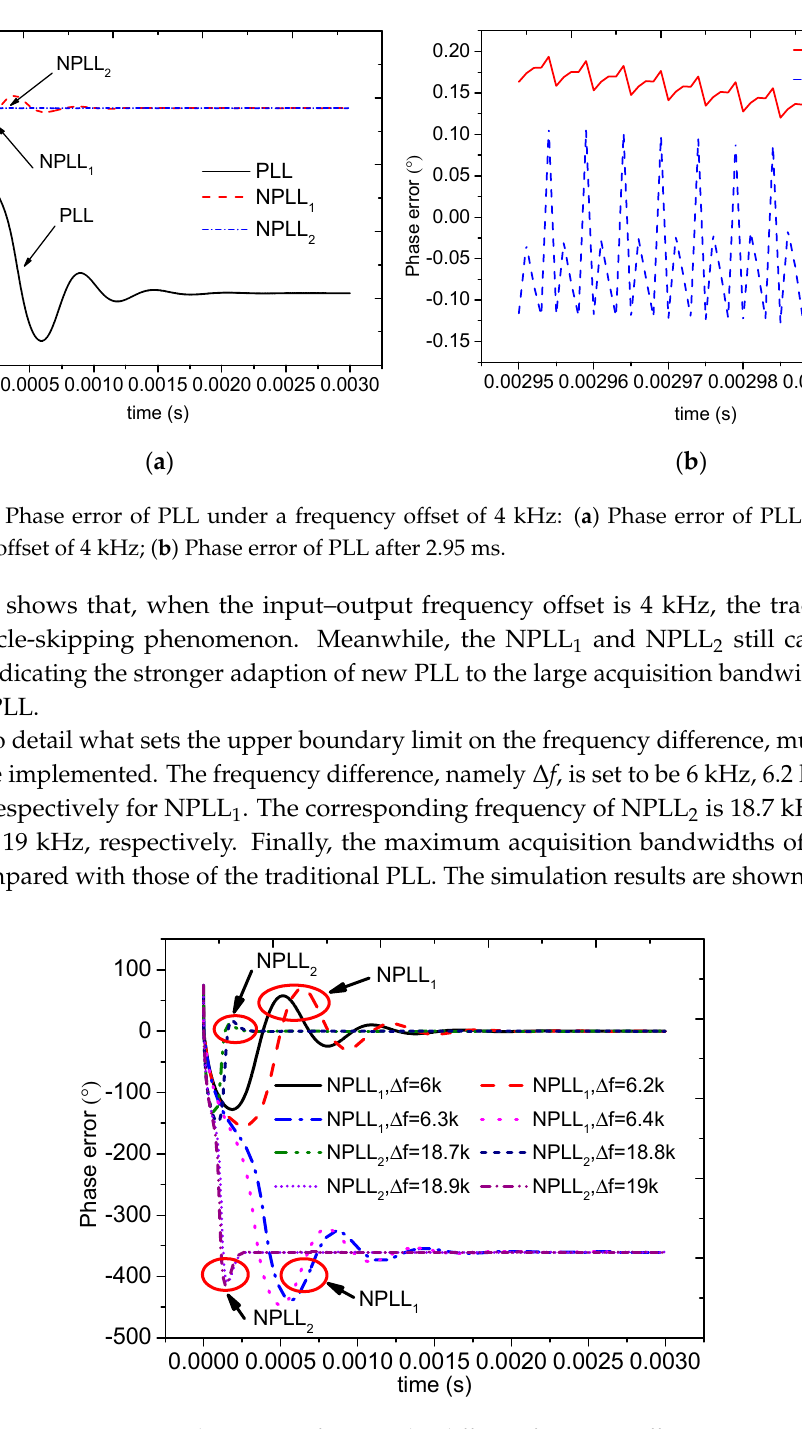
Figure 9. Phase error of PLL under a frequency offset of 1 KHZ: ( a ) phase error of PLL under a frequency offset of 1 kHz; ( b ) phase error of PLL after 2.95 ms.